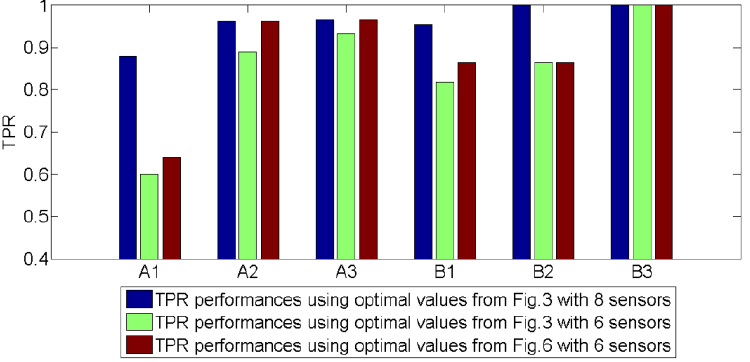
Figure 4. Comparison of TPR